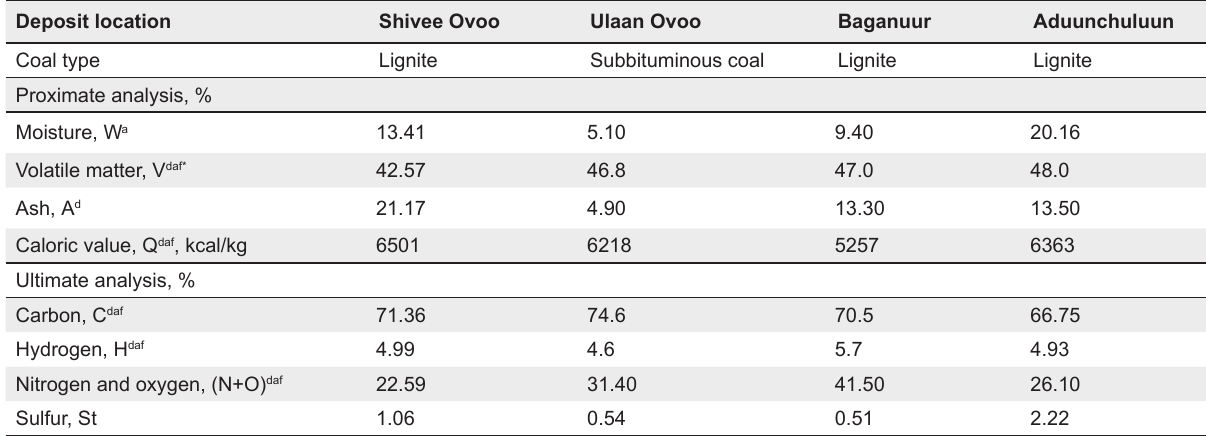
Table 1. The results of proximate and ultimate analyses of coals